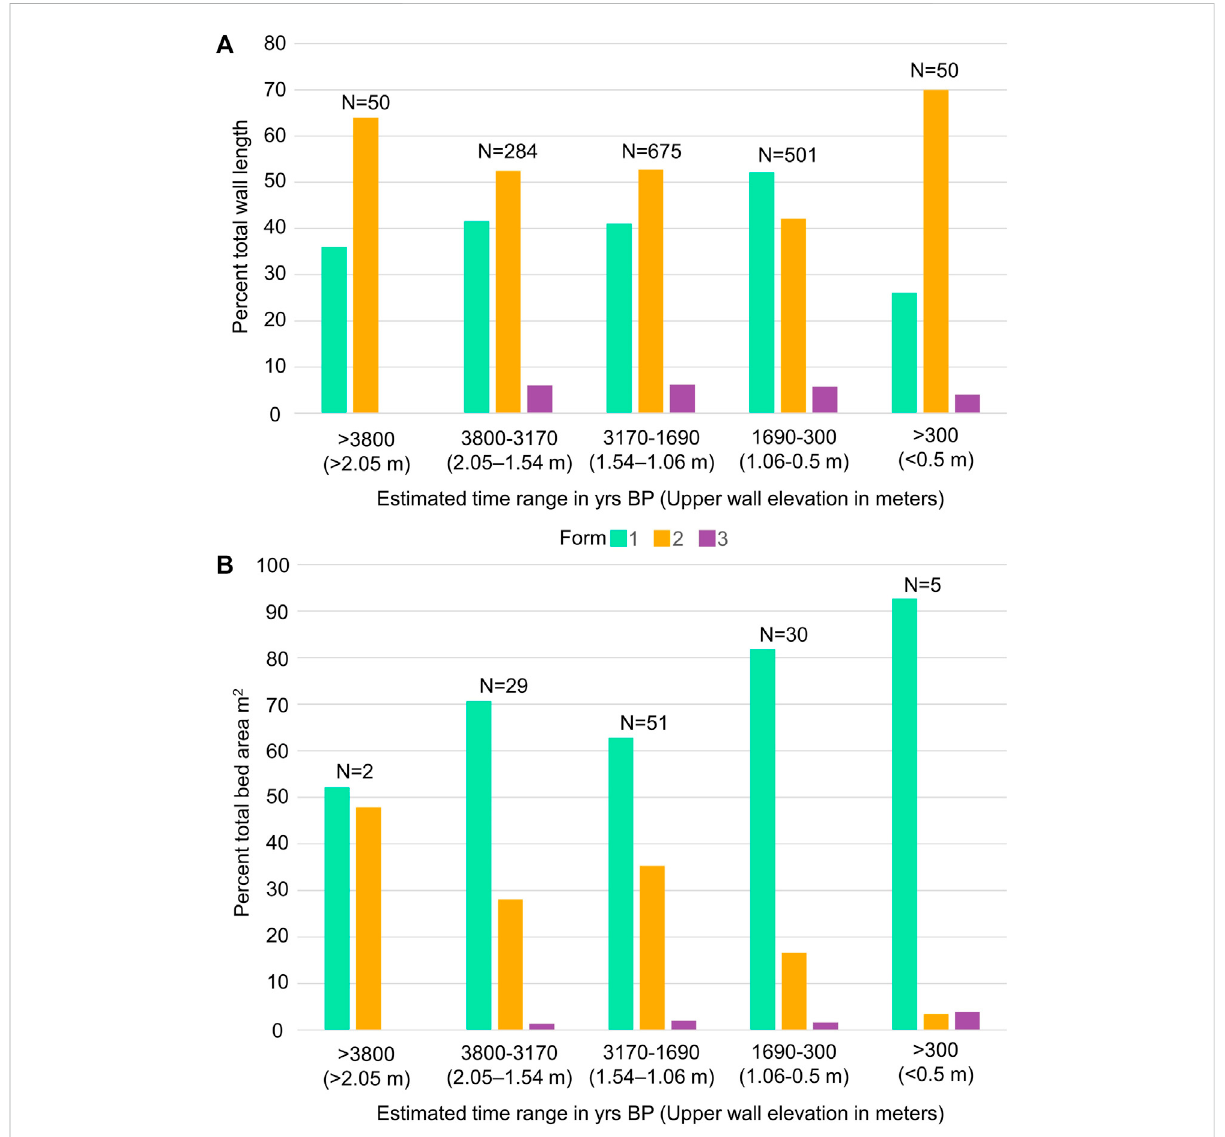
FIGURE 9 (A) Relative percent length and number of wall elevation samples (top of bars) of Forms one, two, and three clam gardens by tidal elevation in Kanish Bay (B) Relative percentarea and number of clam garden beds (N = 108; Lepofsky et al., 2020)of Forms one,two, and three by tidal elevation in Kanish